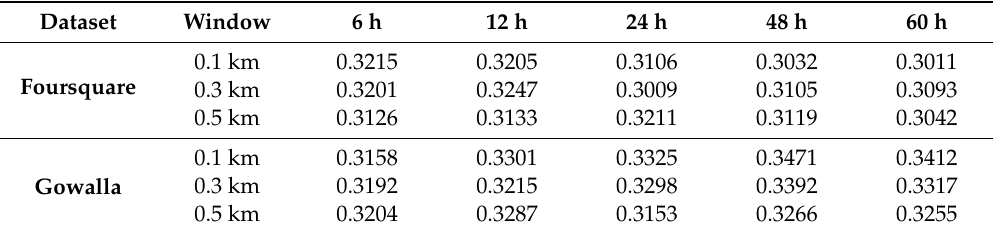
Table 3. Performance of AST-GRU with varying window width by